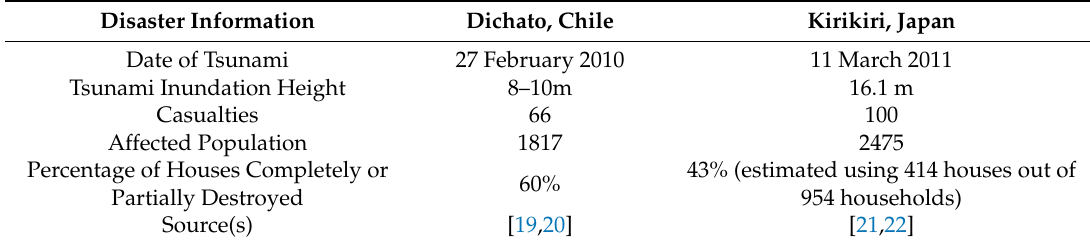
Table 1. Comparison of study